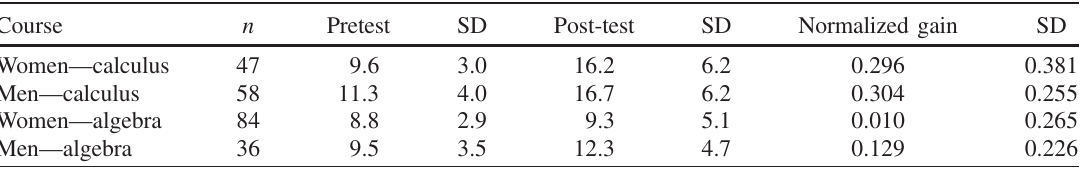
TABLE V. Average scores and SD for pretest, post-test, and normalized gain by gender. Course n Pretest SD Post-test